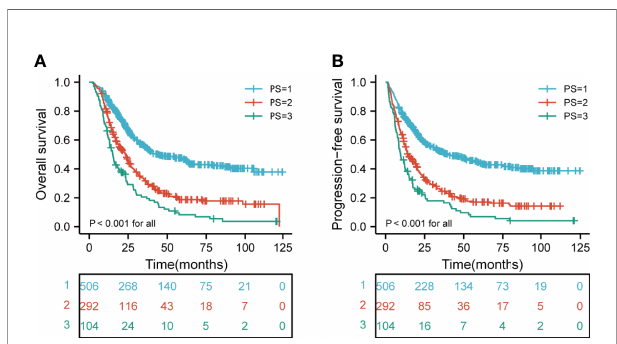
FIGURE 3 | Kaplan-Meier curves according to different risk groups for the whole study population showing (A) Risk strati fi cation for PI on OS (p < 0.001 for all); (B) Risk strati fi cation for PI on PFS (p < 0.001 for all). PI, prognostic index; OS, overall survival; PFS,